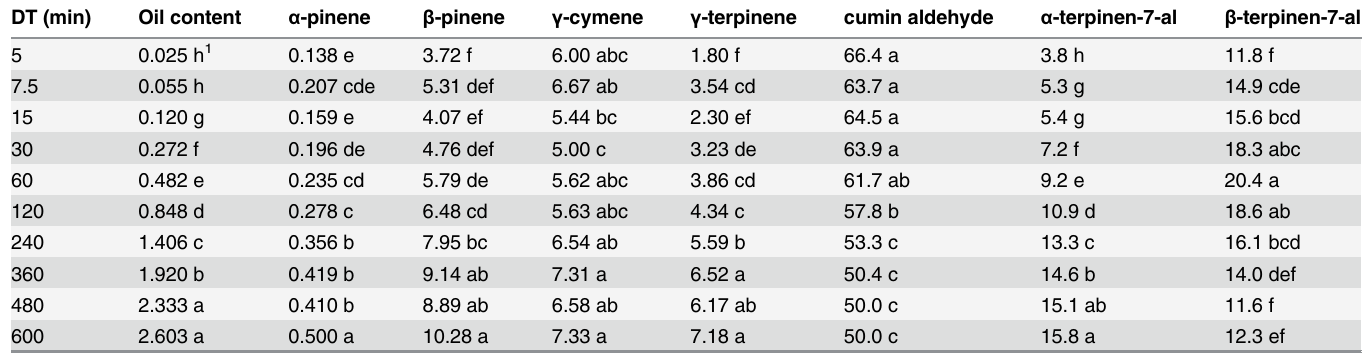
Table 1. Mean oil content (%), and the concentration (%) of α -pinene, β -pinene, γ -cymene, γ -terpinene, cumin aldehyde, α -terpinen-7-al, and β -ter- pinen-7-al obtained from the 10 distillation times (DT). DT